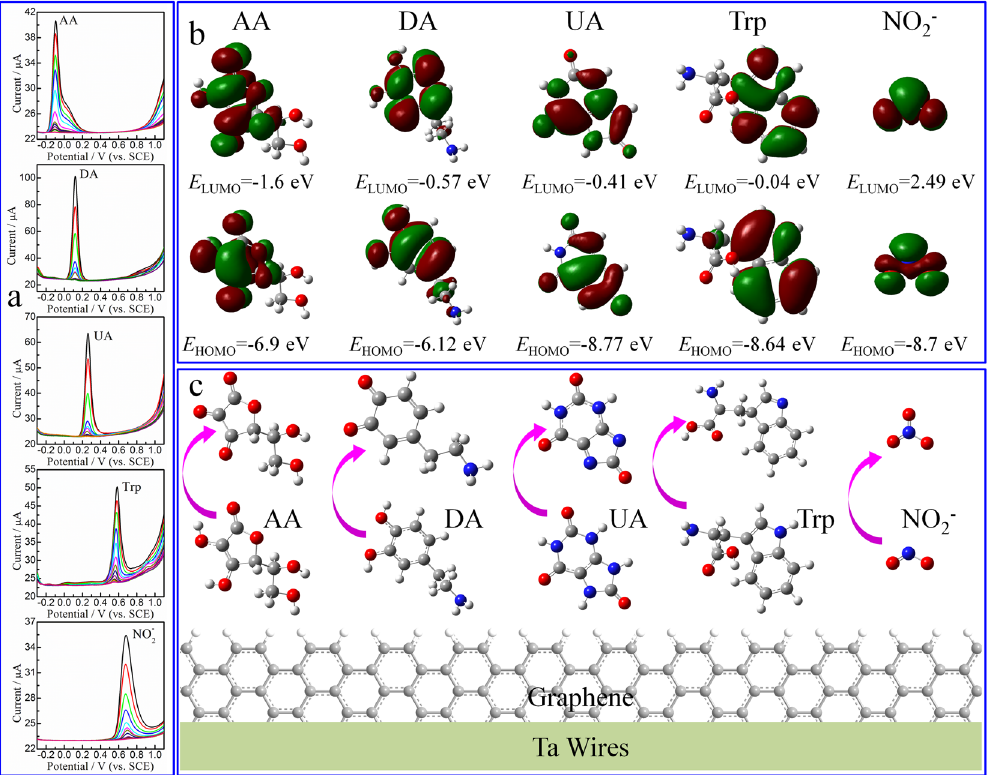
Figure 3. ( a ) DPVs of graphene/Ta wire electrode in pH 7.0 PBS by varying the concentrations of AA, DA, UA, Trp, and − NO . ( b ) Frontier molecular orbitals of AA, DA, UA, Trp, and − NO 2 the biosensing mechanism of the graphene/Ta wire